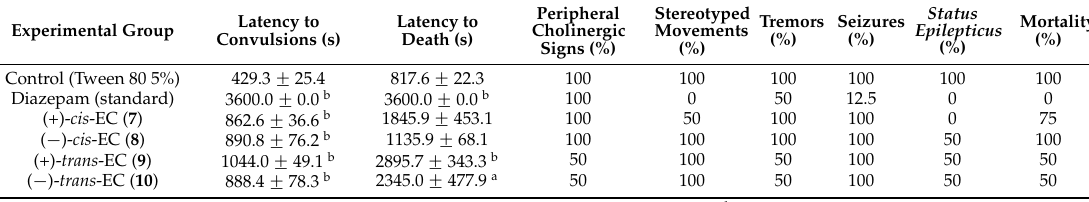
Table 3. Epoxycarvone stereoisomers effect on pilocarpine-induced seizures test. Experimental Group